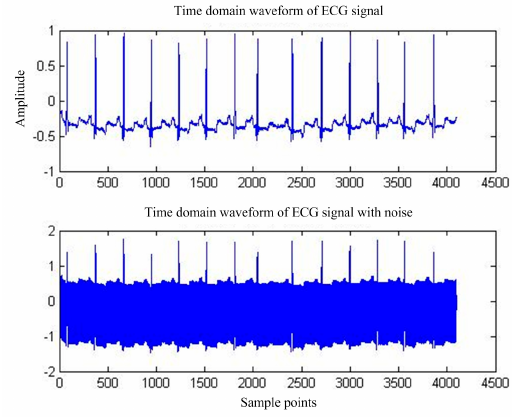
Figure 5. MIT-BIH ECG waveform before and after PLI.